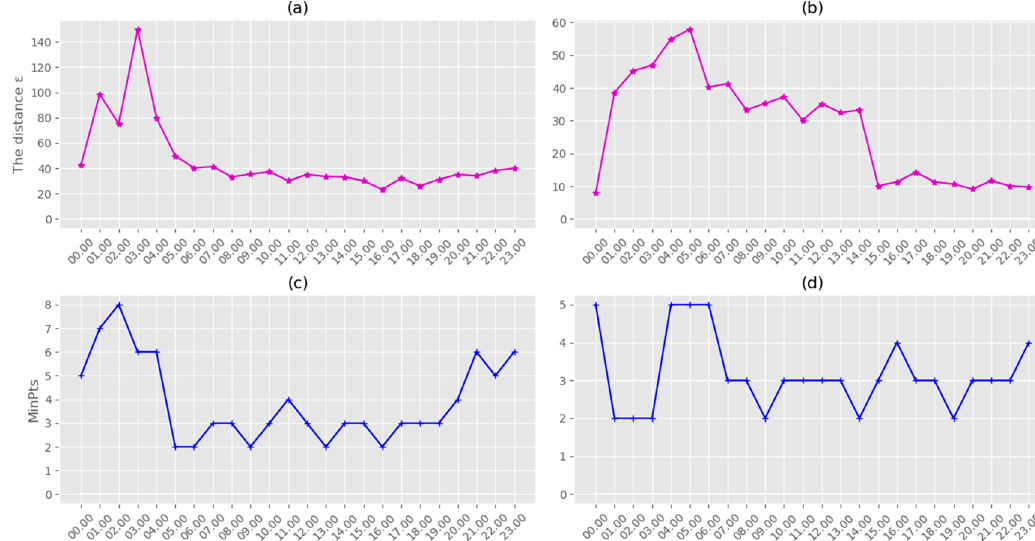
Figure 7. Fluctuation of the distance ε on a normal day ( a ) and a special day ( b ). The MinPts parameter value in the New Year’s Eve ( c ) and on a normal day ( d ).